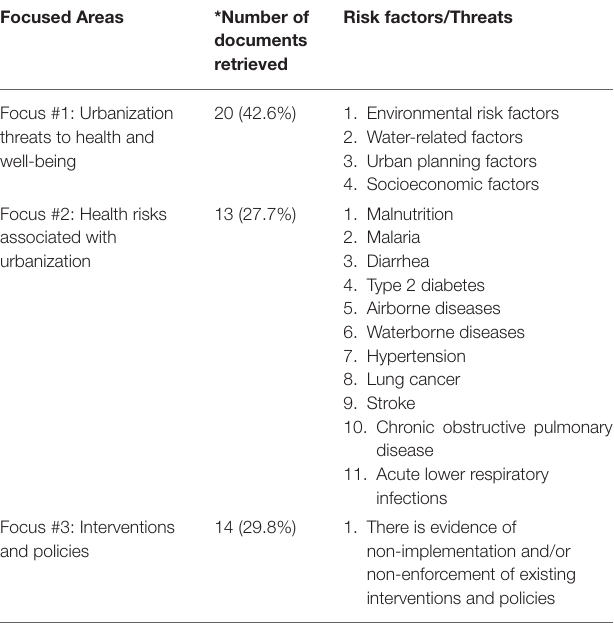
TABLE 1 | Classification of focus areas by number of documents and associated risk factors/threats. Focused